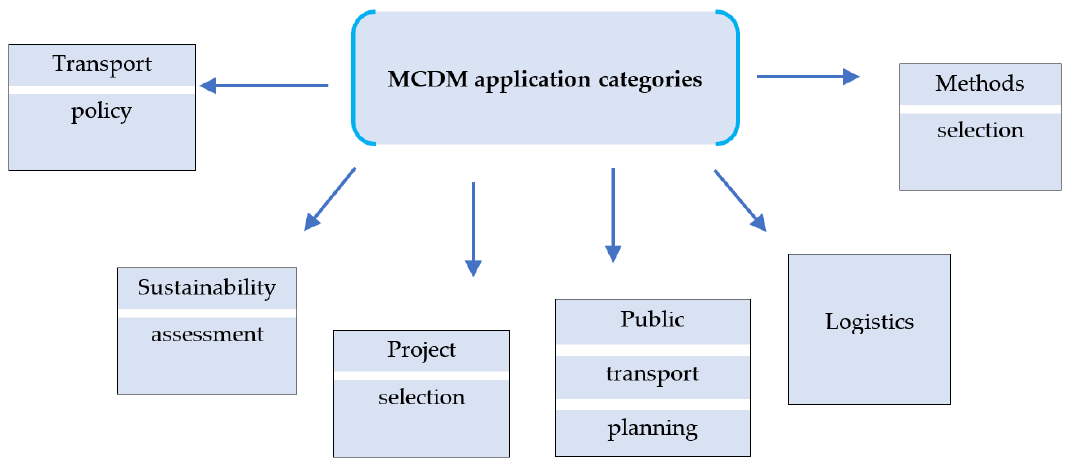
Figure 1. MCMD application areas in sustainable transport decision making.